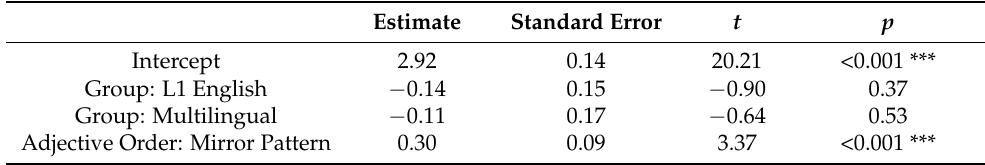
Table 6. Linear model testing the effect of language group and adjective order (mirror pattern, English linear pattern) on acceptability judgements (formula: Acceptability Judgement~Group + Adjective Order + (1|Participant) +